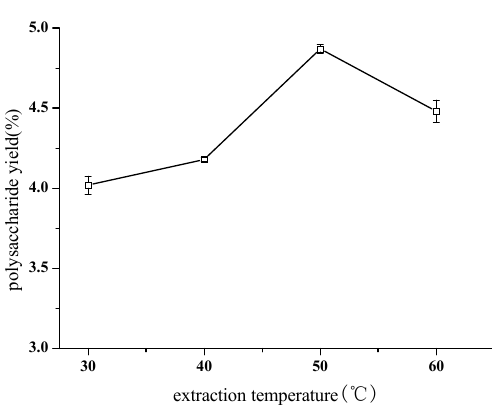
Figure 2. The effect of extraction temperature on polysaccharide yield (w/w dry crushed material %) from TCBL.